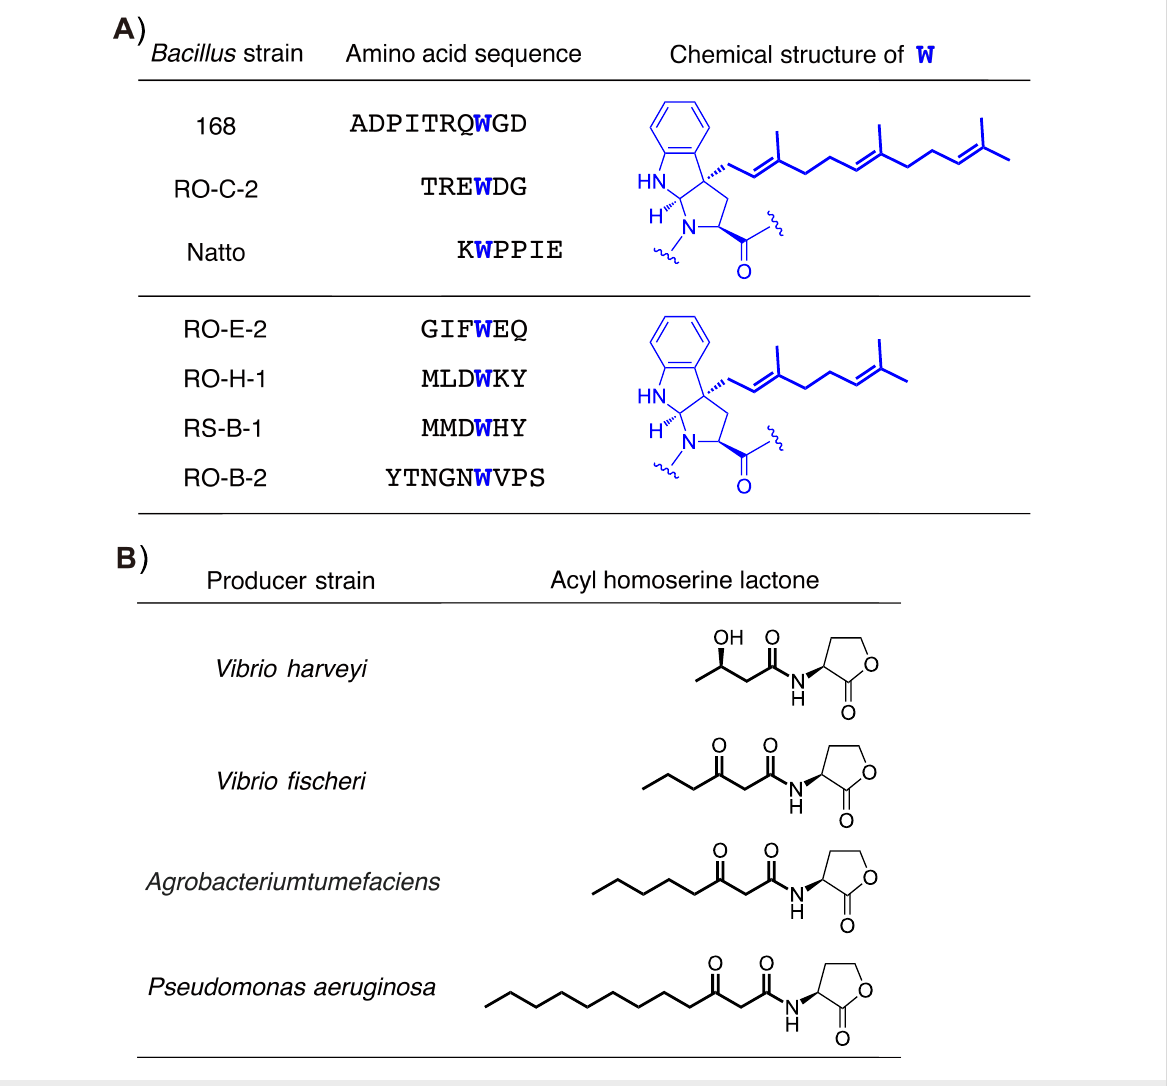
chain in quorum sensing pheromones are probably a common strategy to acquire group specificity in